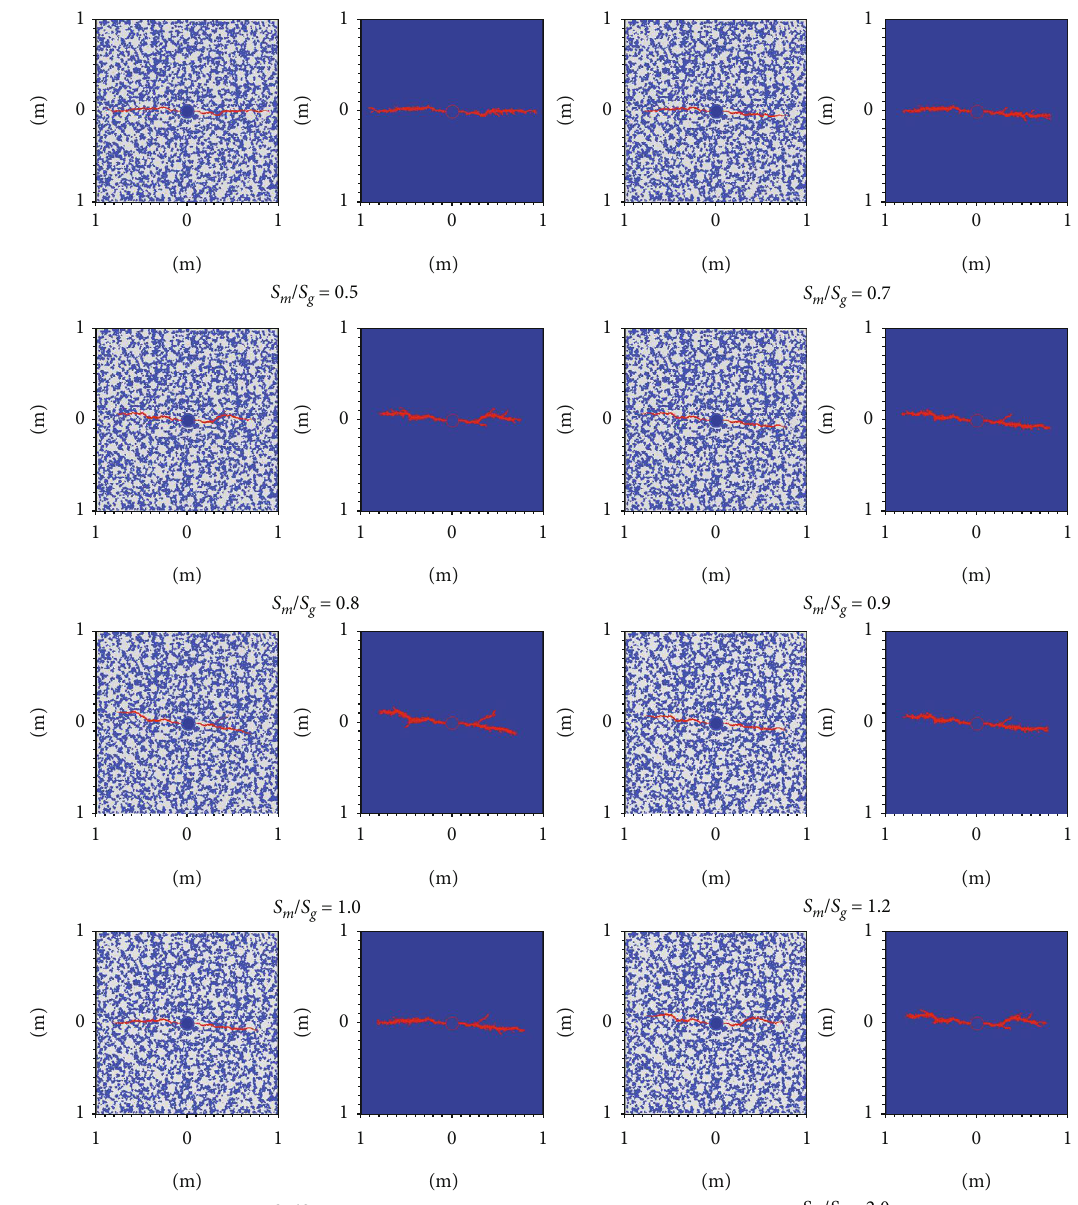
Figure 13: HF propagation morphology under di ff erent ratios of the shear strength of the matrix to